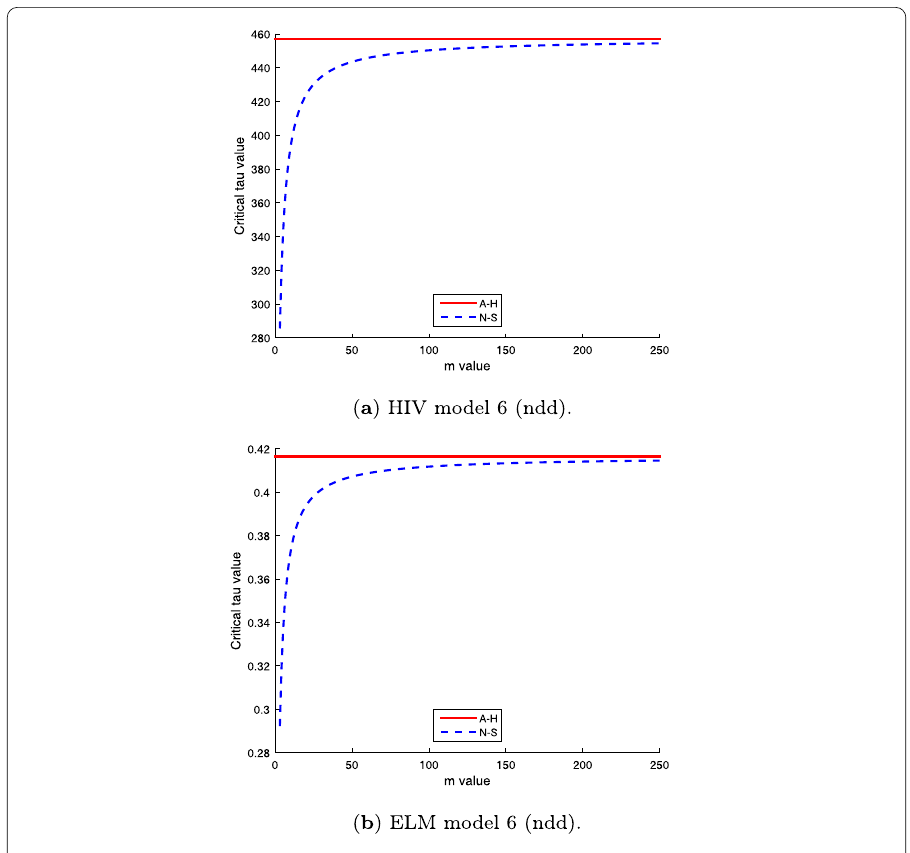
Figure 8 Plots showing convergence of Neimark–Sacker critical delay values for increasing m to Andronov–Hopf critical delay values for HIV and ELM version